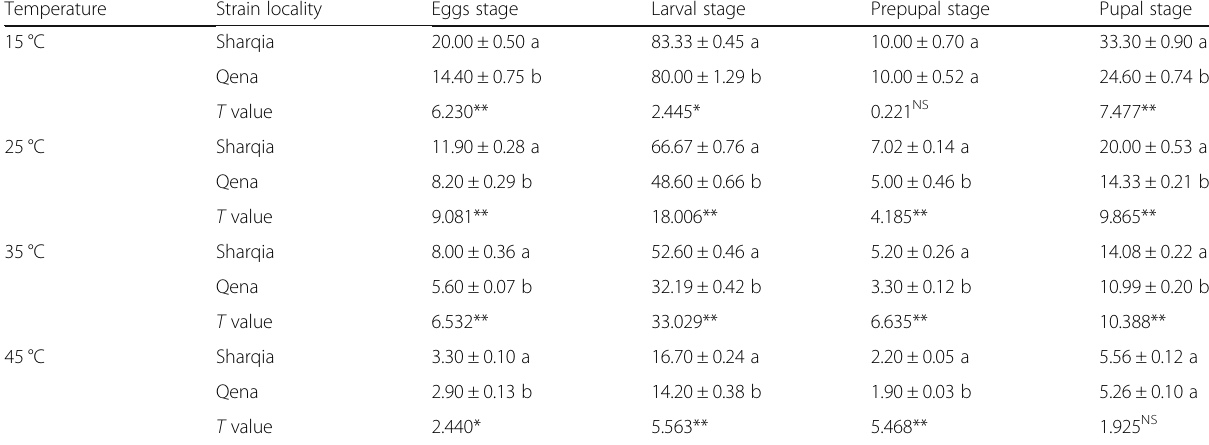
Table 2 Duration of different treated stages of O. nubilalis under different constant temperatures